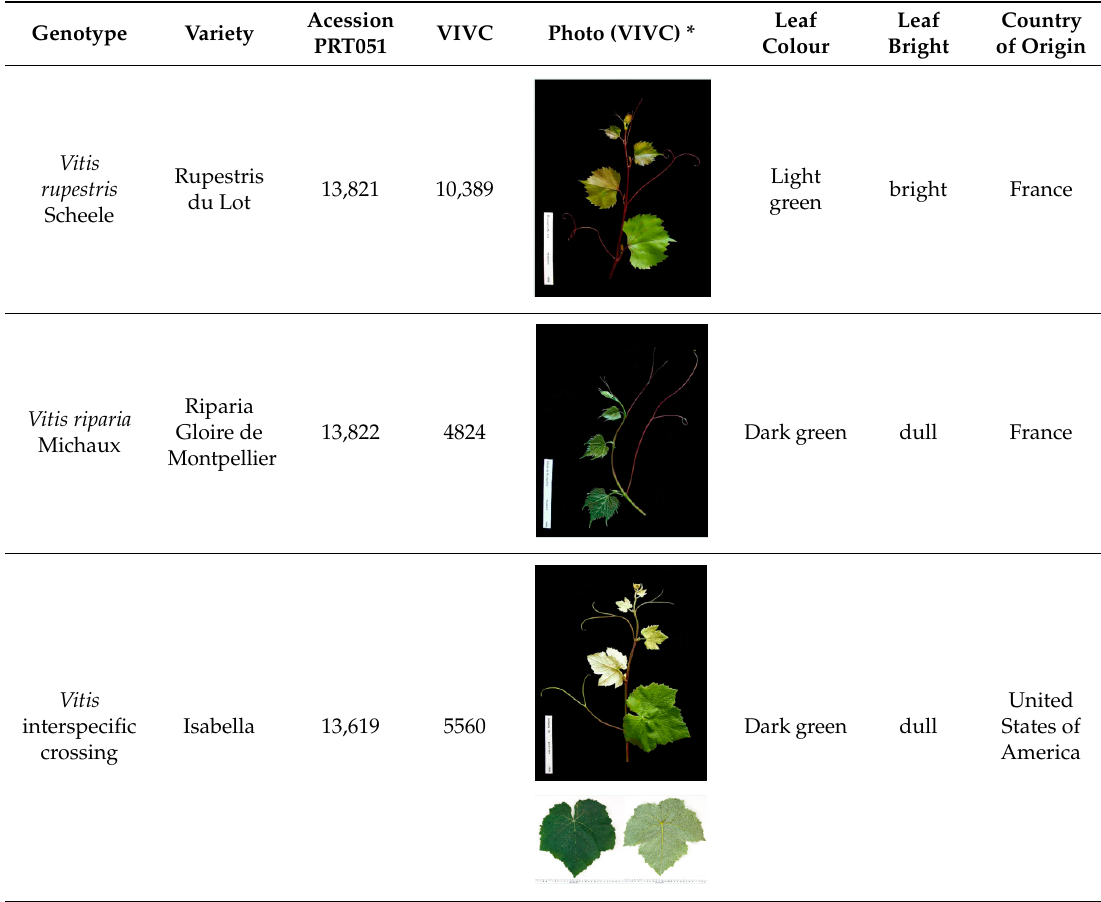
Table 2. Grapevine genotypes used in this study. Grapevine species, variety and V. vinifera name, accession on the Portuguese National Ampelographic Collection, number on the Vitis International Variety Catalogue [38], leaf traits and country of origin are shown.